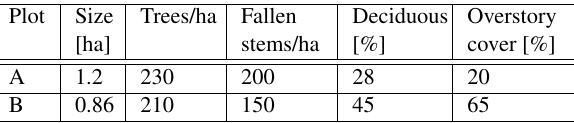
Table 1: Properties of sample plots